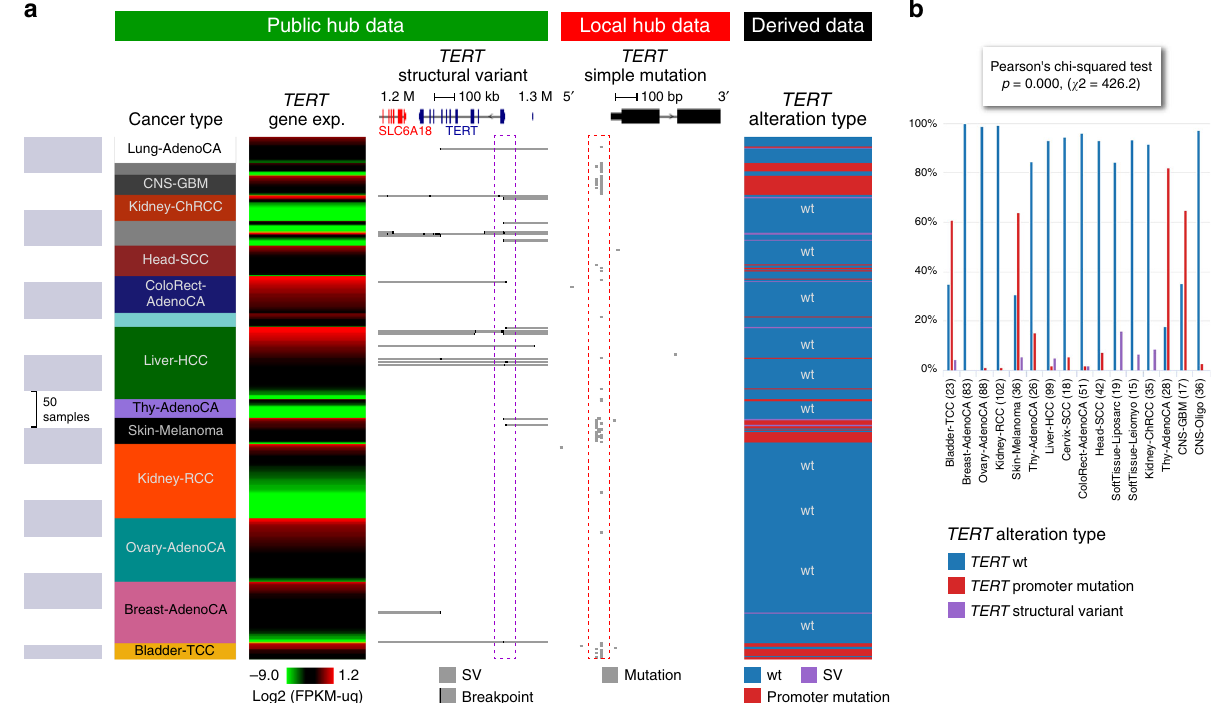
Fig. 2 UCSC Xena views of TERT across cancer types. a Visual spreadsheet view of TERT multi-omics data across PCAWG cancer types. Data from the PCAWG public hub are under the green section, and protected data from the user ’ s local Xena hub are under the red section. The public and private datasets are integrated in the browser, keeping the private data protected. Many of the cancer types show TERT alterations, either as simple somatic mutations in the promoter region (as seen in the pileup highlighted in the red box) or as structural variants (as seen in the breakpoint pileup upstream of TERT highlighted in the purple box). Only cancer types that have a TERT alteration are displayed ( n = 718 samples). The last column, dynamically generated in the browser, shows which samples have promoter mutations, which have structural variants, and which have none. No sample is observed to have both promoter mutations and structural variants; hence, the two types of alterations are mutually exclusive. b Distribution of different types of TERT alterations across cancer types, as shown in Xena chart view. Xena automatically runs the appropriate statistical test for every chart; in this case, Xena calculated that the difference in distributions across cancer types is statistically signi fi